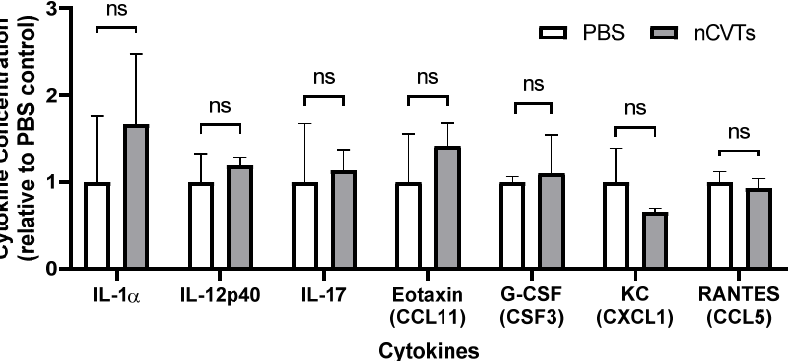
Figure 4. Plasma cytokine concentrations 24 h post-intravenous administration of nCVTs relative to PBS control. Other cytokines (not indicated in the figure) are below the detection limit. ns indicates not significant ( p > 0.05).